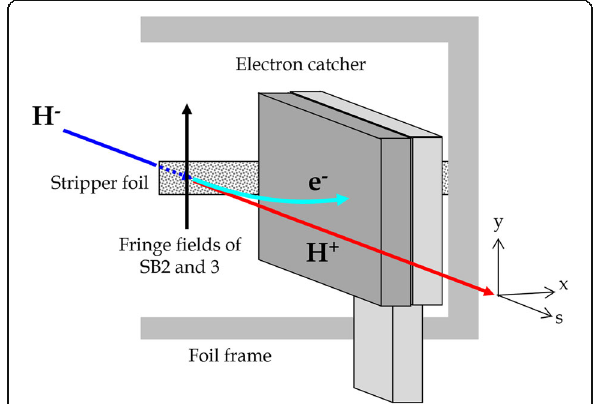
Fig. 12 Schematic of the electron catcher installed in the J-PARC RCS